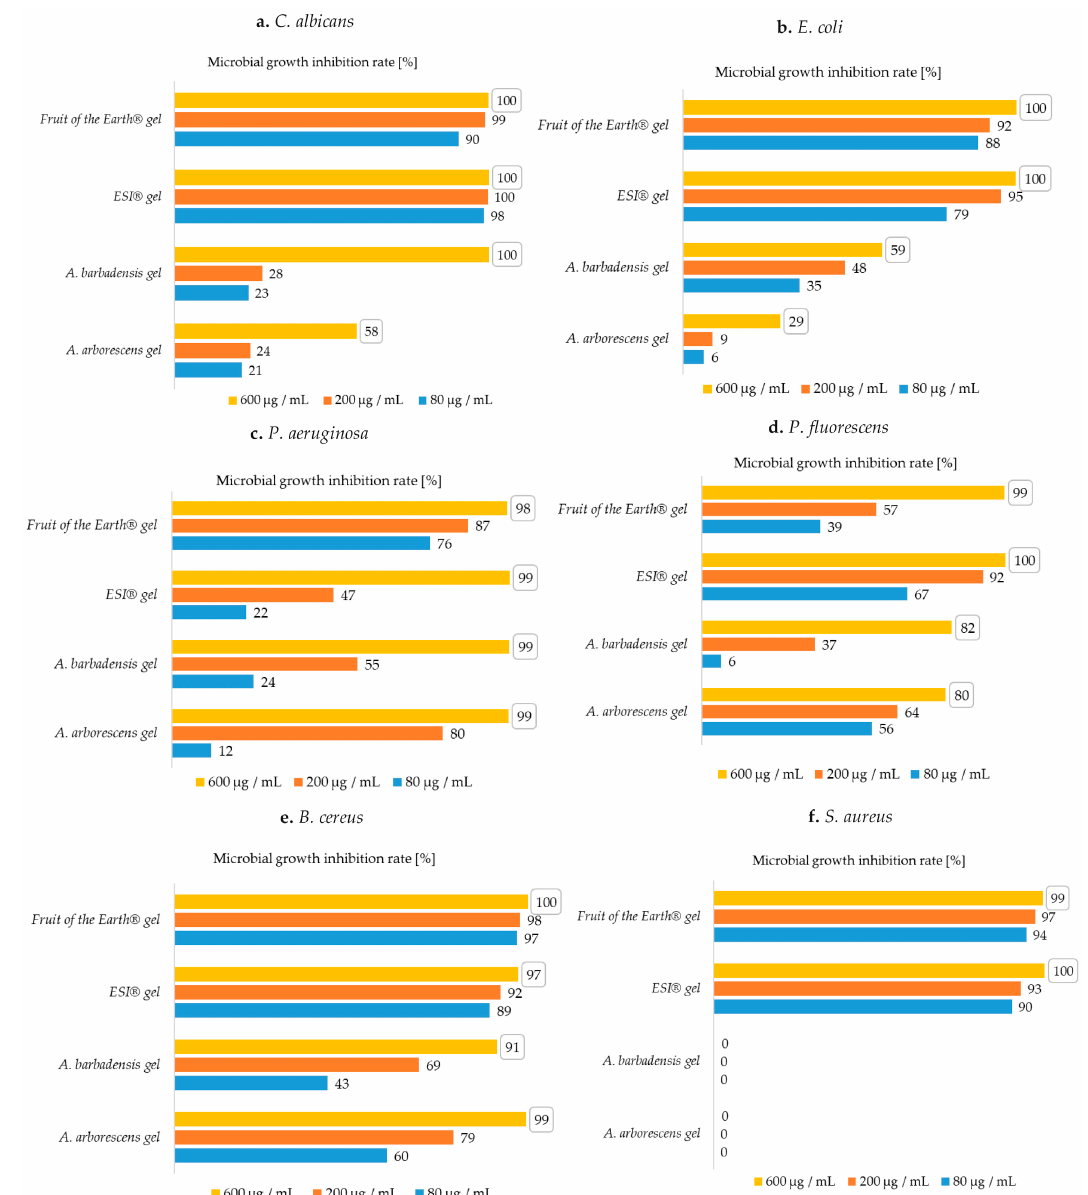
Figure 2. MGIRs for aloe gels using 600, 200, and 80 µ g juice/mL suspension; ( a )—MGIRs for C. albicans ; ( b )—MGIRs for E. coli , ( c )—MGIRs for P. aeruginosa , ( d )—MGIRs for P. fluorescens , ( e )—MGIRs for B. cereus , ( f )—MGIRs for S. aureus ; The numbers in the boxes are the highest achieved MGIRs for each sample. (Initial concentrations of microorganisms: C. albicans 10 6 CFU/mL, E. coli 10 7 CFU/mL, P. aeruginosa 10 7 CFU/mL, P. fluorescens 10 7 CFU/mL, B. cereus 10 7 CFU/mL, S. aureus 10 5 CFU/mL); standard deviations were max. ±